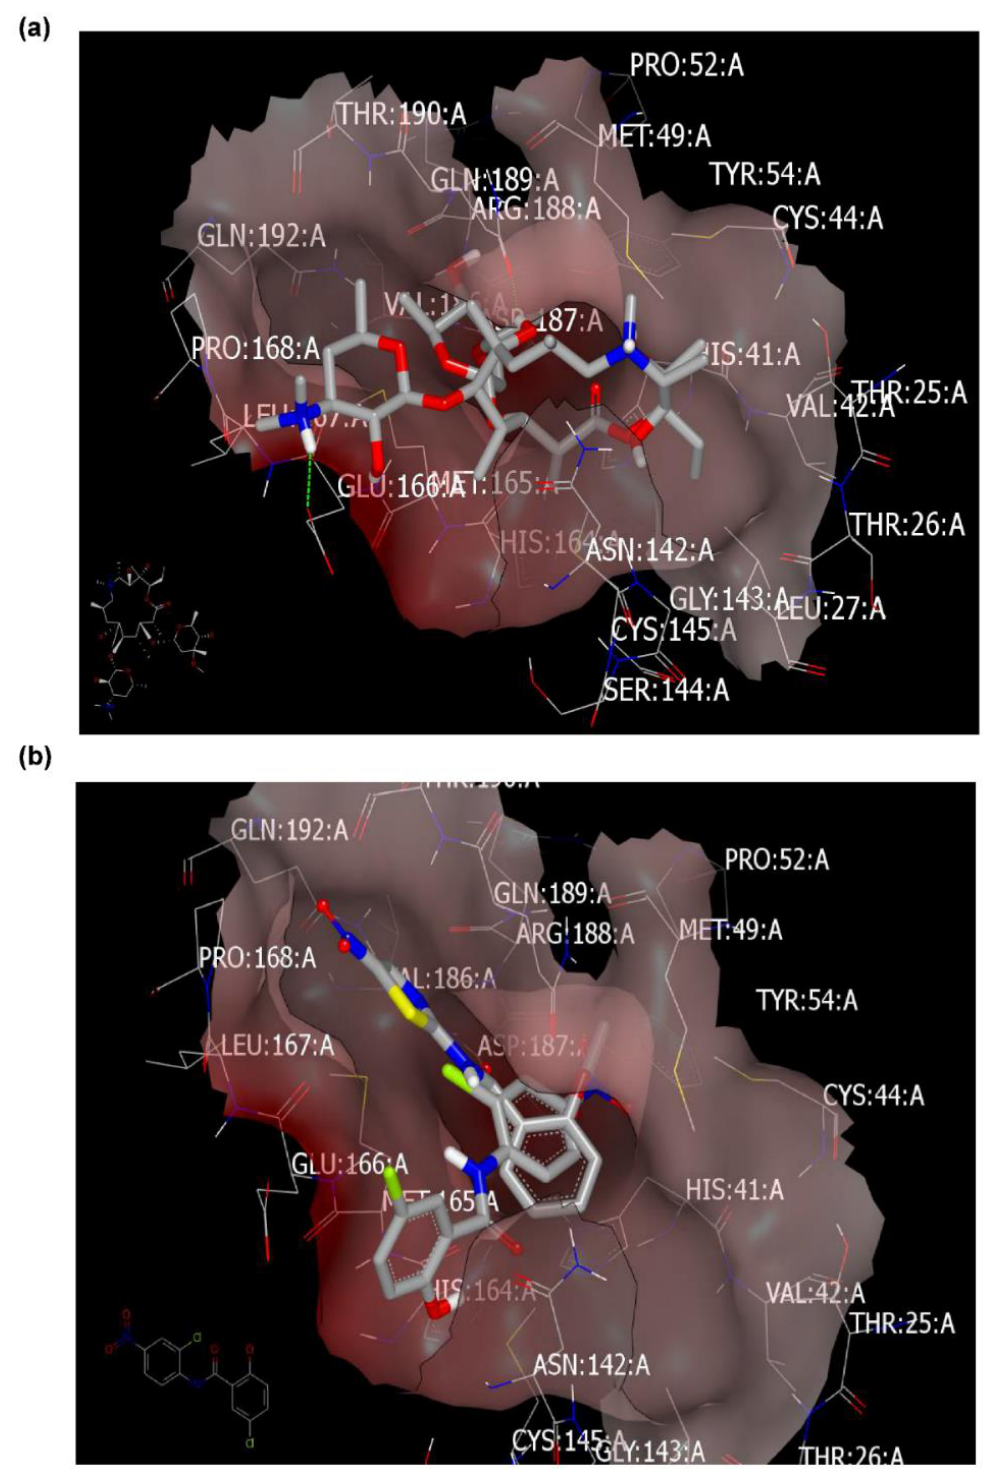
Figure 3. Visual representation by volumetric image display and analysis (VIDA) of docking with M pro (PDB ID: 6lu7). ( a ) Azithromycin docked with the formation of two HBs (green color). ( b ) Niclosamide (grey color) and Nitazoxanide (thiazole ring with yellow-blue color) occupied the active site without detection of HB.